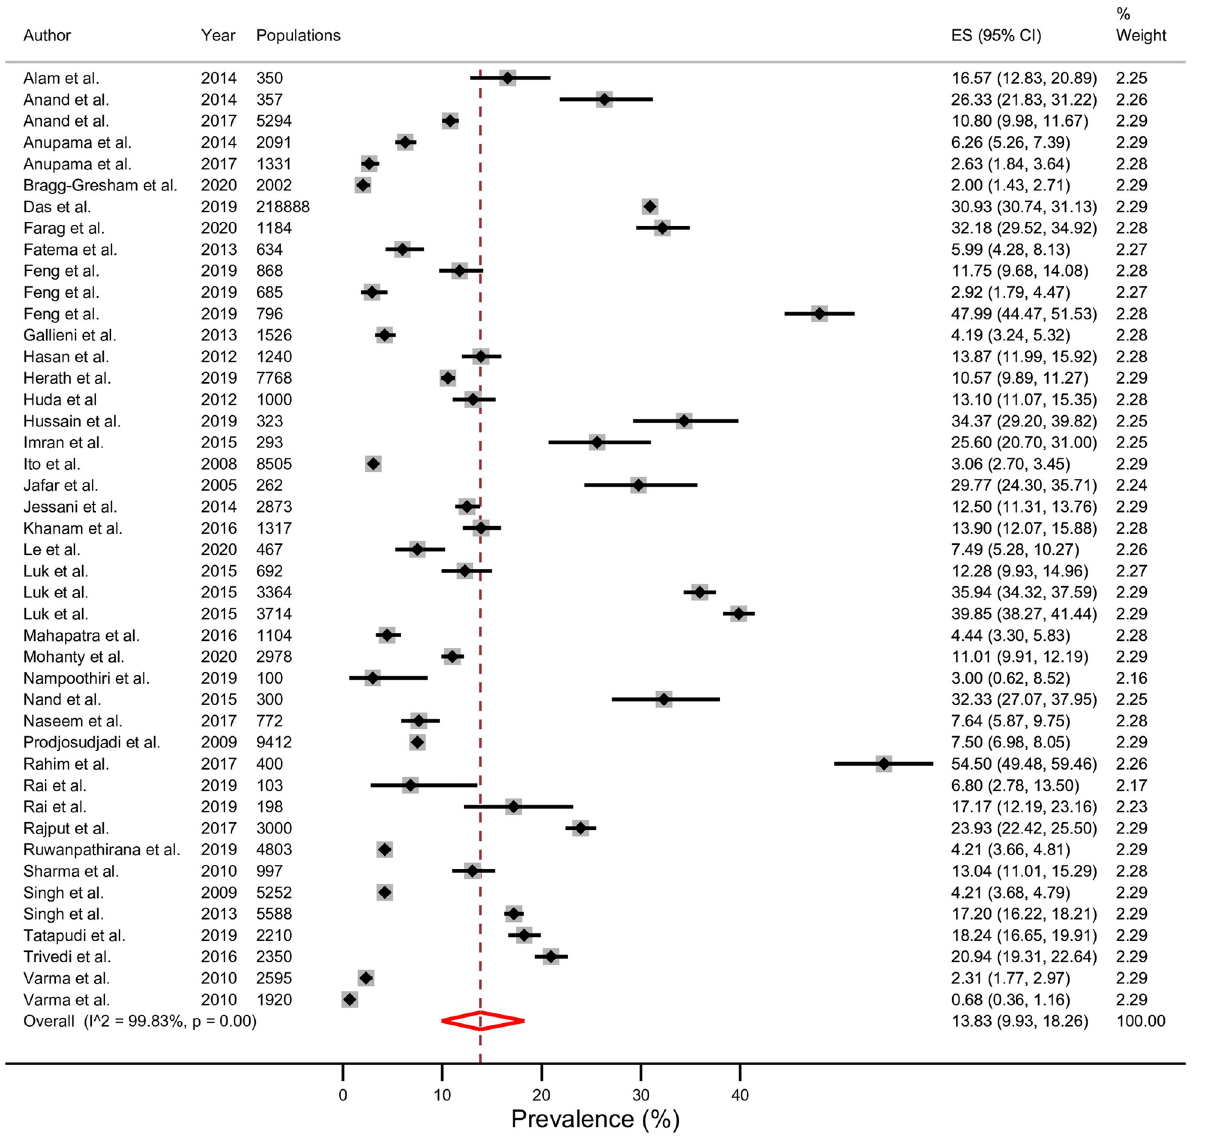
Fig 5. Prevalence of chronic kidney disease (CKD) stages 3–5 in lower-middle income countries using a random-effects model. https://doi.org/10.1371/journal.pone.0264393.g005 (OR = 1.45), hypercholesterolemia (OR = 1.33), low level of high-density lipoprotein choles- terol (OR = 1.28), history of coronary heart disease (recalculated OR using trim-and-fill analy- sis for publication bias = 1.99), history of stroke (OR = 4.88) and history of cardiovascular disease (OR = 2.76). Furthermore, CKD was significantly associated with five non-traditional risk factors, including education level (OR = 2.01), hyperuricemia (OR = 2.74), anemia (OR = 2.80), family history of CKD (OR = 2.82) and nonsteroidal anti-inflammatory drugs (NSAIDs) use (OR = 1.97). On the contrary, this meta-analysis found the insignificant associa- tions between CKD stages 3–5 and gender, marital status, lower body weight, dyslipidemia, high level of low-density lipoprotein cholesterol (LDLc), smoking status, alcohol consumption, physical activity, family history of hypertension, and CD4 cell count in HIV patients (Table 3).